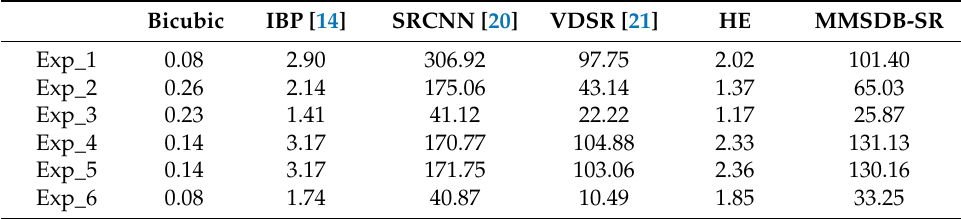
Table 7. The running time (s) of different SRR methods with 2 × up-scaling